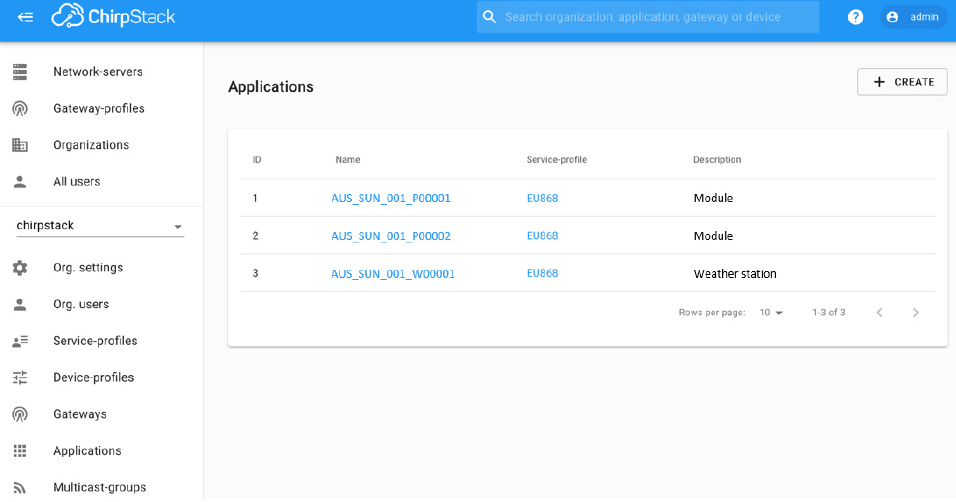
Figure 3. Chirpstack web interface.